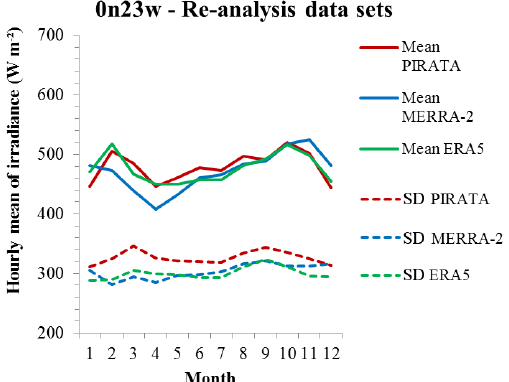
Figure C6. Monthly means (solid lines) and standard deviations (dotted lines) of hourly DSIS, in Wm − 2 , from PIRATA measurements (red) and data sets (MERRA-2: blue, ERA5: green) at 0 ◦ N, 23 ◦ W. A difference between red line (measurements) and coloured line (data set) for a given month denotes a systematic error for this month: underestimation if the coloured line is below the red line, overestimation otherwise. For a given month, a coloured dotted line above the red one means that the data set produces too much variability for this month; in the opposite case, the data set does not contain enough